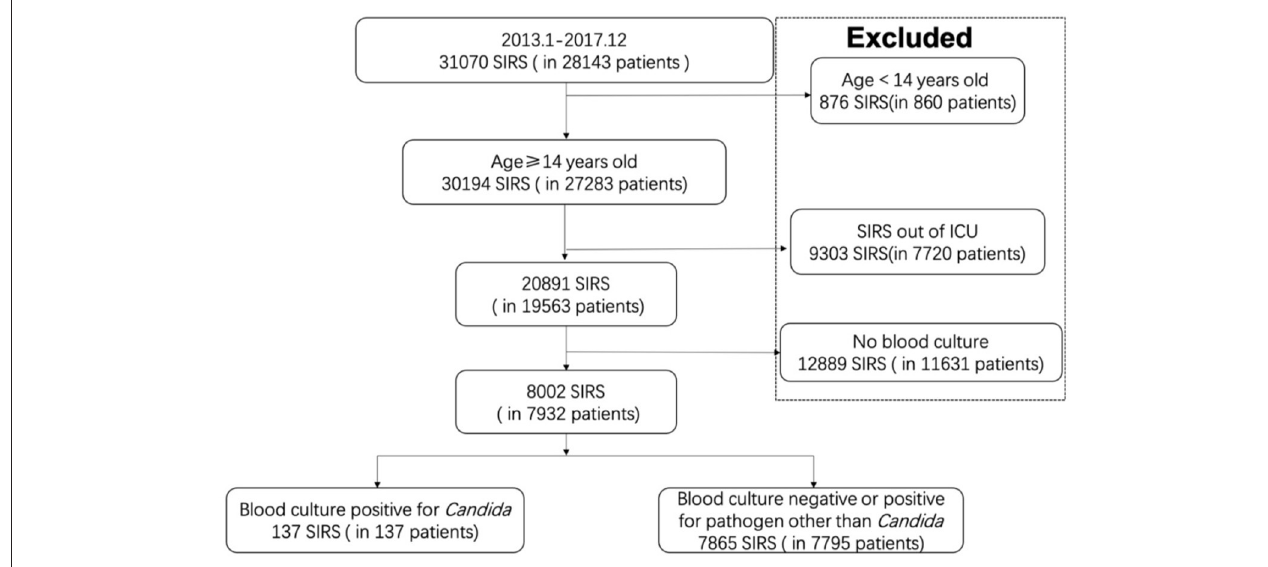
FIGURE 1 | Flowchart for